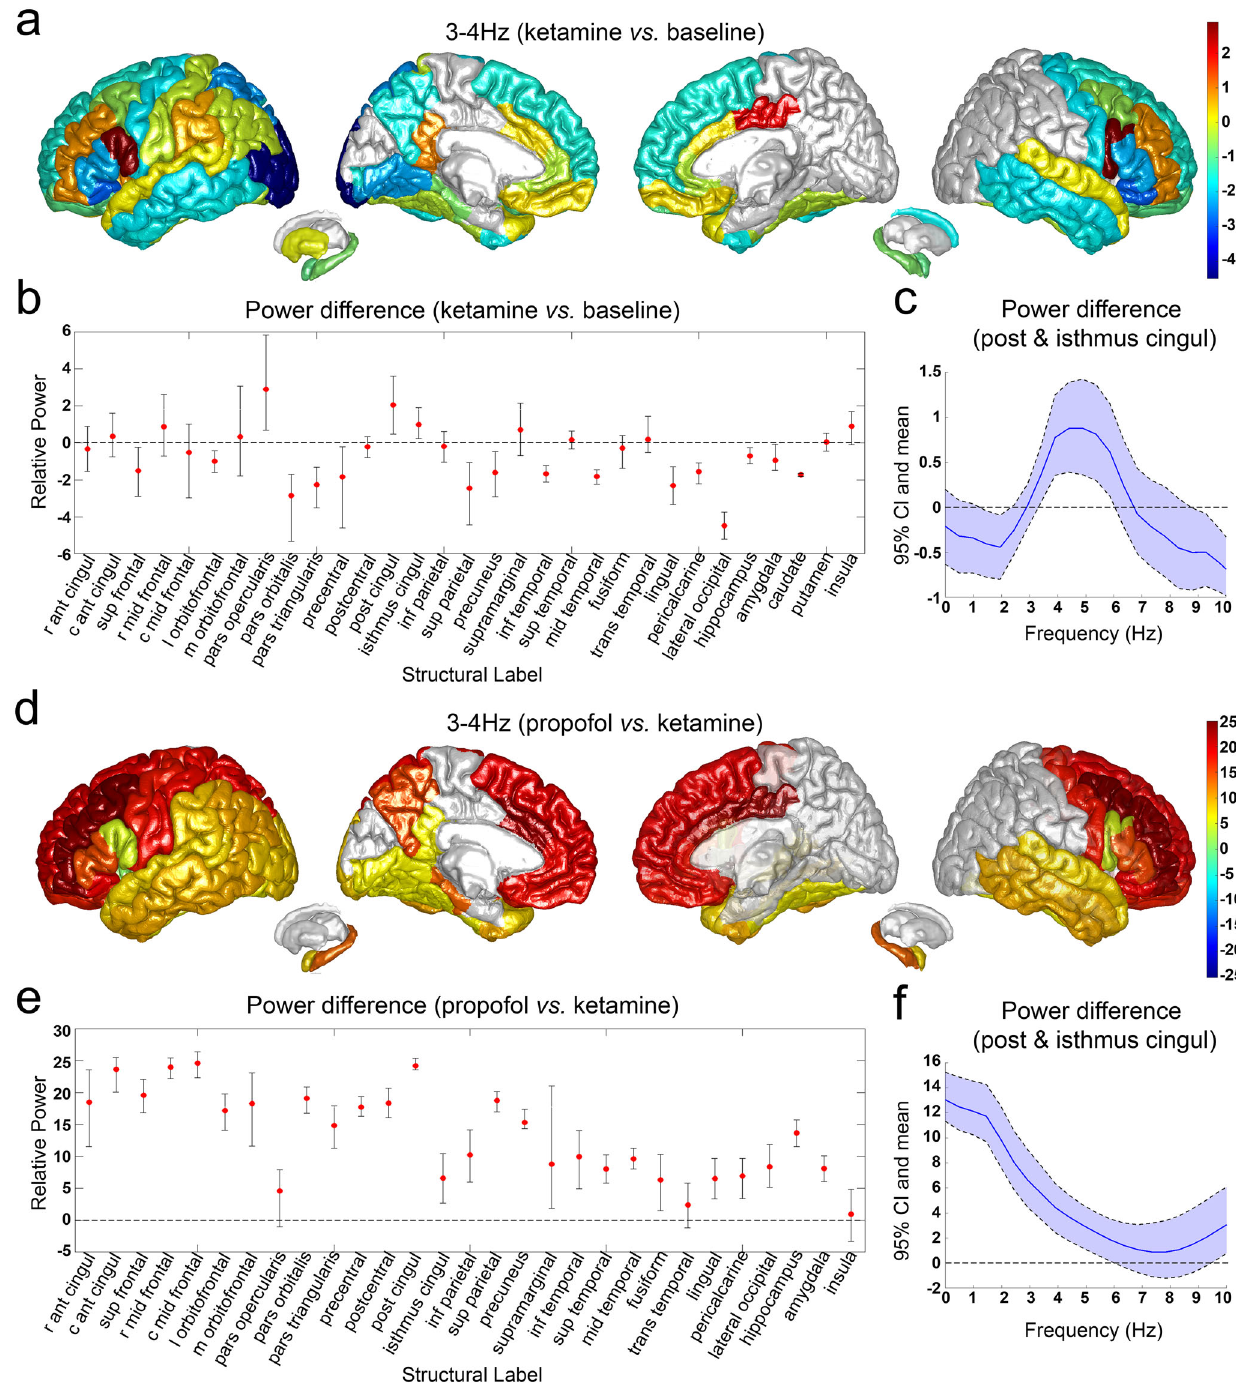
Fig. 4 | Analysisof3 – 4HzintracranialEEG powerchangesafter administration of ketamine and propofol. a , Structural mapping for 3 – 4Hz intracranial EEG power(dB)changesafterketamineinfusion. b ,Meanandbootstrap95%con fi dence interval (CI) for 3 – 4Hz intracranial EEG power (dB) changes after ketamine infu- sion. c Power spectrum for posterior and isthmus cingulate cortex after ketamine infusion. Data are presented as mean and bootstrap 95% CI. d Structural mapping for 3 – 4Hz intracranial EEG power (dB) changes after propofol bolus. e Mean and bootstrap 95% CI for 3 – 4Hz intracranial EEG power (dB) changes after propofol bolus. f Power spectrum for posterior and isthmus cingulate cortex after propofol